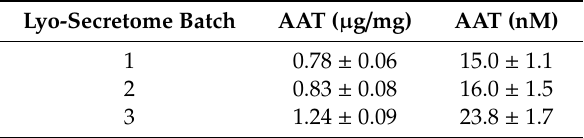
Figure 2. Total protein and lipid content of freeze-dried secretome collected between 0–24 and 24–48 h of serum starvation; mean values ± standard deviation, n = 3. Table 1. Alpha-1-antitrypsin (AAT) content of three lyo-secretome batches produced after 48 h of serum starvation. Results are expressed as µ g of protein per mg of sample and mathematically converted to nM, based on a molecular weight of 52 kDa; mean values ± standard deviation, n =